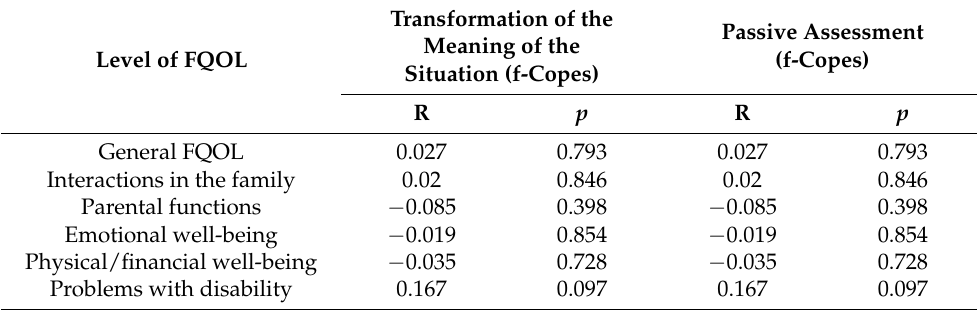
Table 3. Transformation of the meaning of the situation (F-COPES) and passive assessment of the situation versus the level of FQOL in the assessment of children and adolescents with SI. Transformation of the Passive Assessment Meaning of the (f-Copes) Level of FQOL Situation (f-Copes) R p R p General FQOL 0.027